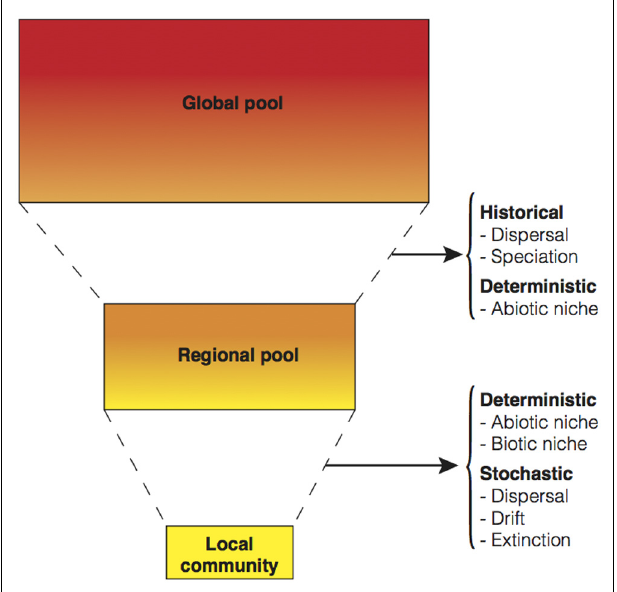
FIGURE 1 | Conceptual summary of the main processes influencing community composition, structure, and diversity at different spatial scales. All ecological and evolutionary processes considered have been encapsulated in three perspectives: deterministic (i.e., the biotic and abiotic niche), stochastic, and historic. It can be argued that each one of the processes may have deterministic, stochastic, and historic components. For example, dispersal may be stochastic when rates depend solely on population size, deterministic when traits that affect arrival and establishment are considered, and also historic if the information of past events is available. Additionally, although the same process can operate at different scales, in this simplistic model as spatial scale increases historical processes tend to be more relevant, while at small local scale stochasticity can play an important role. As follows, speciation often requires geographic barriers, diverse niches and/or large population sizes to take place. On the contrary, the stochastic change in the abundance of organisms (drift) that can eventually result in extinction is more important at small population sizes.The demarcation of discrete spatial scales is arbitrary and will be dependent on the study system in